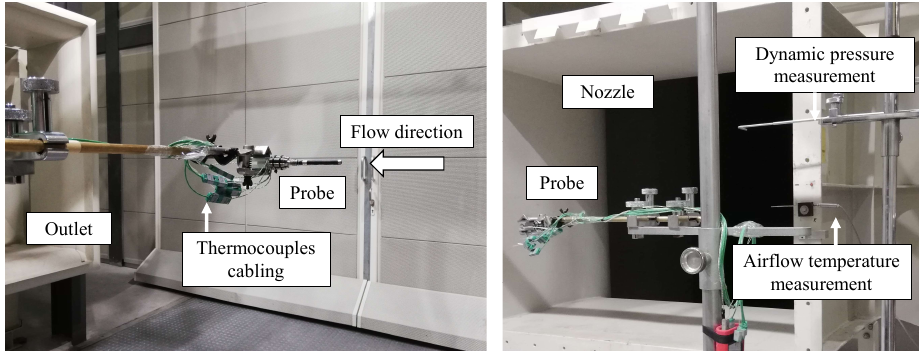
Figure 10. Position of the probe in the wind tunnel test area and relevant setup